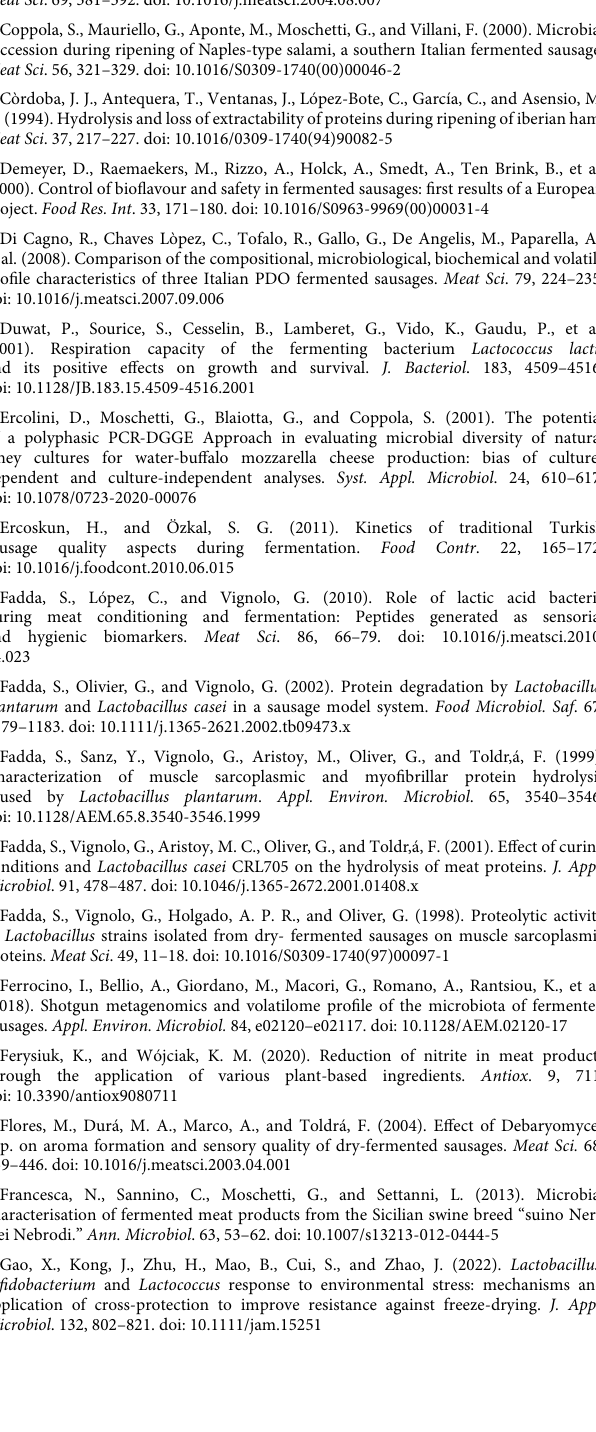
SUPPLEMENTARYFIGURES1 Example of DGGE profile obtained by the DNA extracted from patinas of